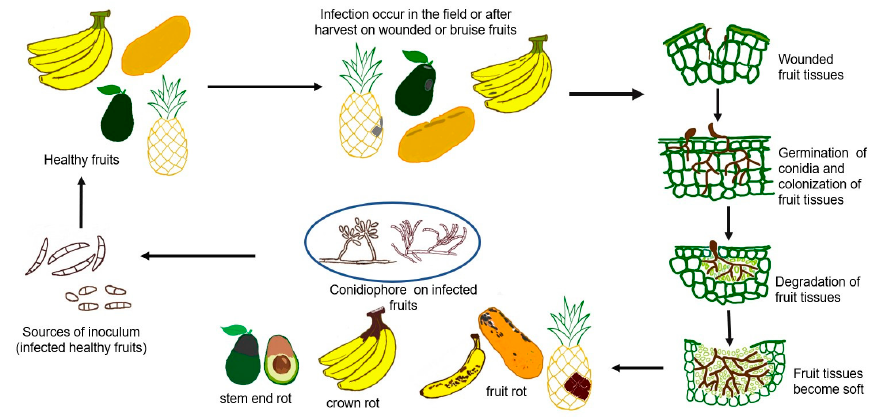
Figure 2. Disease cycle of Fusarium postharvest diseases on major tropical fruit crops. Fusarium oxysporum and F. solani are the most commonly associated with tropical fruit crops. Both species mainly inhabit the soil and are widespread throughout tropical regions. The most well-known disease associated with these species is vascular wilt [7]. Currently, both species are species complexes, comprised of numerous cryptic species or phylogenetically similar species. In addition to F. oxysporum and F. solani, F. incarnatum (syn. F. semitectum ), F. proliferatum , and F. verticilliodes are also commonly reported to be associated with major tropical